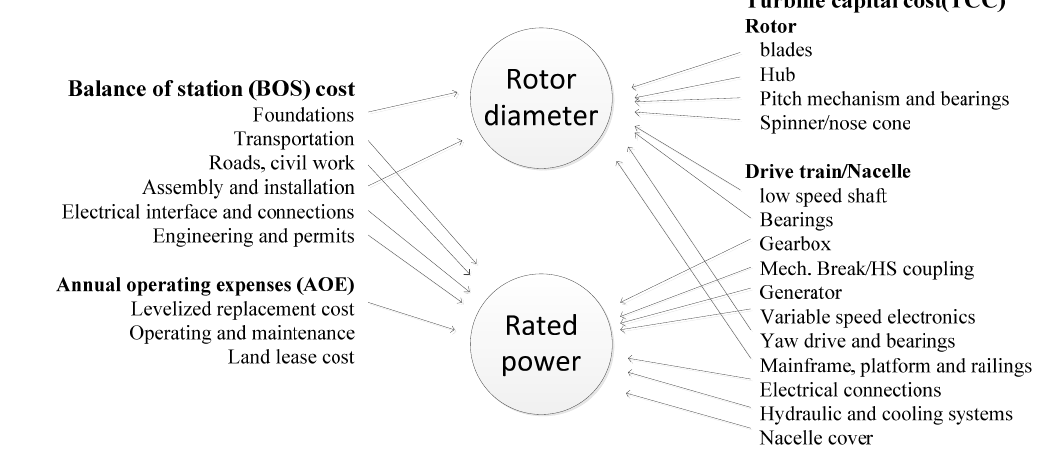
Figure 10. Relationship of rotor diameter and rated power to the components of wind turbine. After the design procedure is finished, the iterative course of the optimization process by considering rated power is shown in Figure 11. It can be seen that the optimal results converge when the number of iteration steps reach 80.